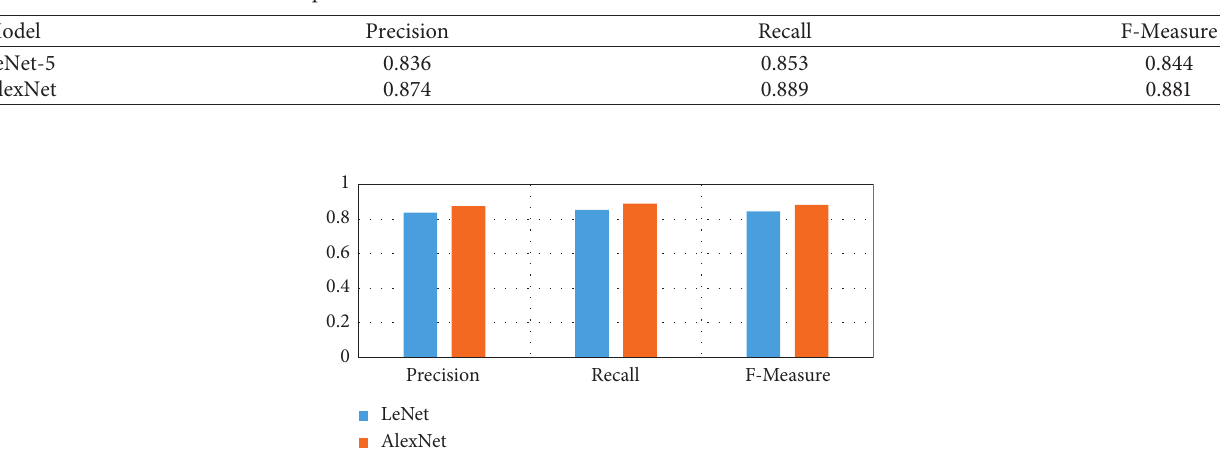
Table 3: Performance comparison of both LeNet-5- and AlexNet-based models in Precision, Recall, and F-Measure.